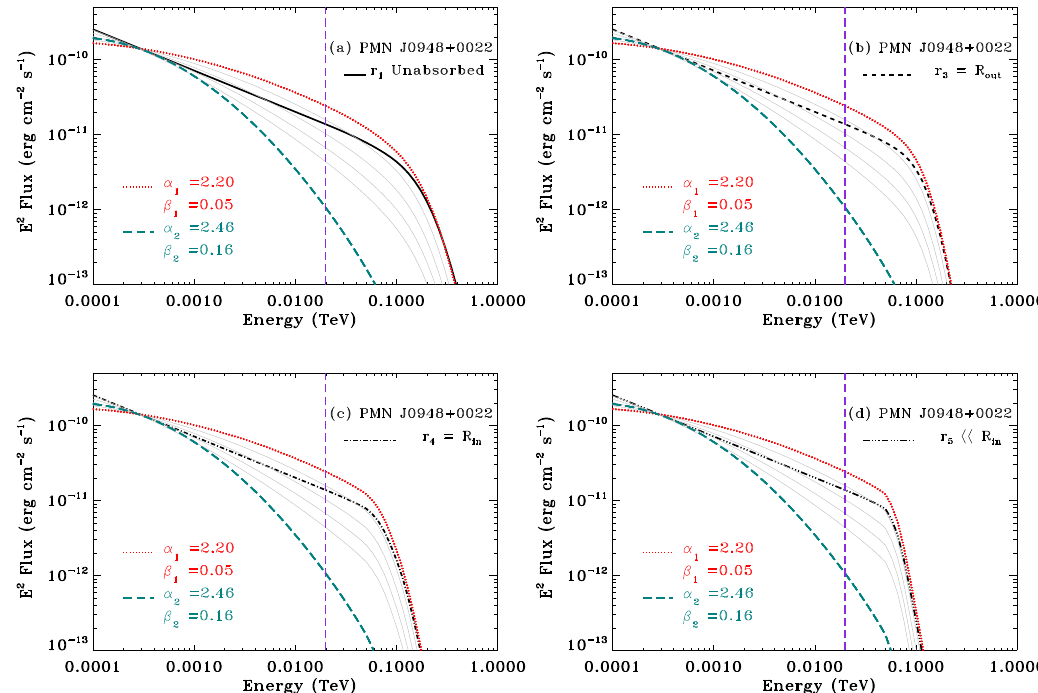
Figure 4. Spectral energy distribution in the energy range 100MeV–1TeV for PMN 0948 + 0022. ( a ) R em = r 1 (cid:29) R BLR ; ( b ) R em = r 3 = R out ; ( c ) R em = r 4 = R in ; ( d ) R em = r 5 (cid:28) R in . The vertical purple dashed line at E = 20GeV represents the CTA energy lower bound.